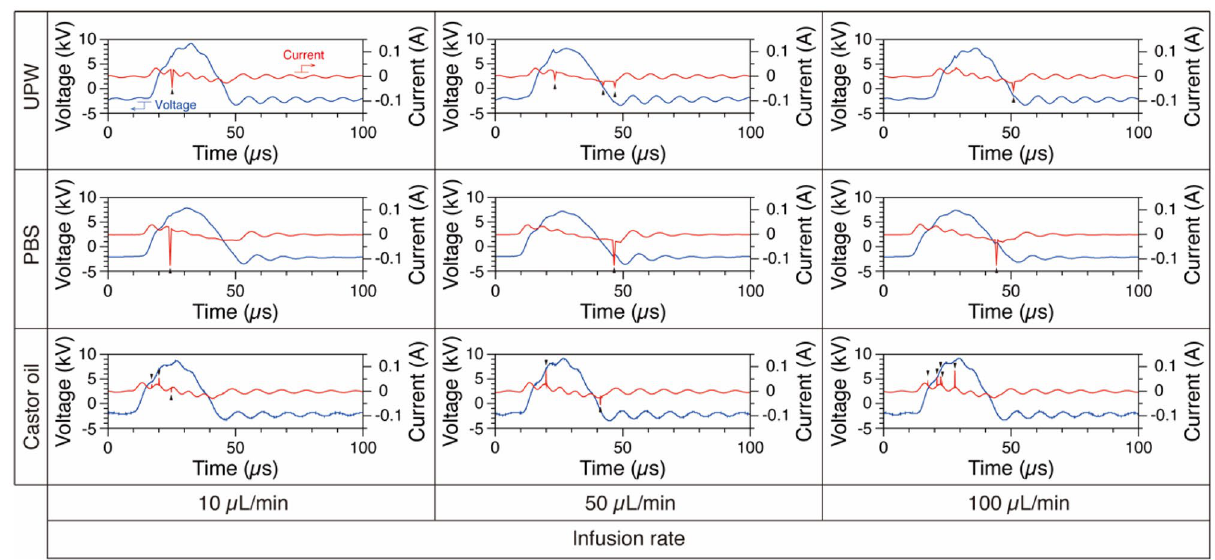
Figure 5. Comparison of waveforms of the applied voltage (blue) and discharge current (red) when each solution is infused at a flow rate capable of generating nano-sized mist. Black arrows indicate discharge current pulses. UPW, ultrapure water; PBS, phosphate buffered saline.